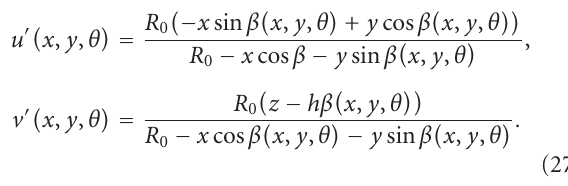
β ( x , y , θ ) = θ + γ (cid:4) ( x , y , θ ), and γ (cid:4) ( x , y , θ ) = arcsin(( − x sin θ + y cos θ ) /R 0 ). The variables u (cid:4) and v (cid:4) are computed by